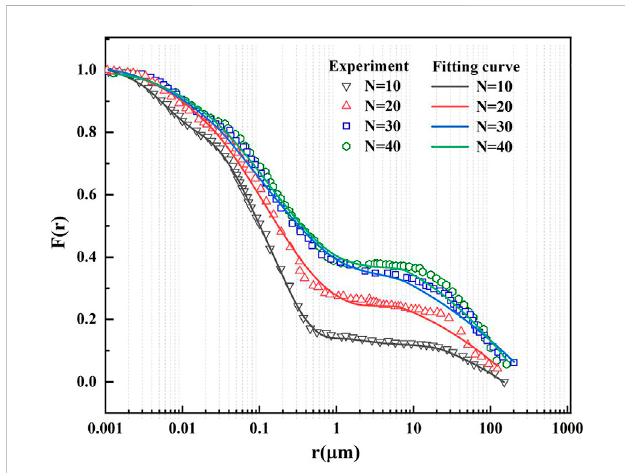
FIGURE 7 The volume components of pores after different freeze-thaw